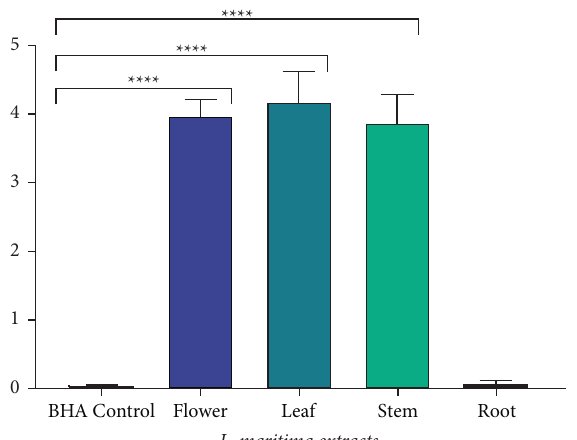
Figure 1: EC 50 values in free radical scavenging activity of the Lobularia maritima extracts against DPPH free radical. Values were means ± SD of triplicate (ns: p > 0 . 05; ∗∗∗∗ : p ≤ 0 . 0001).